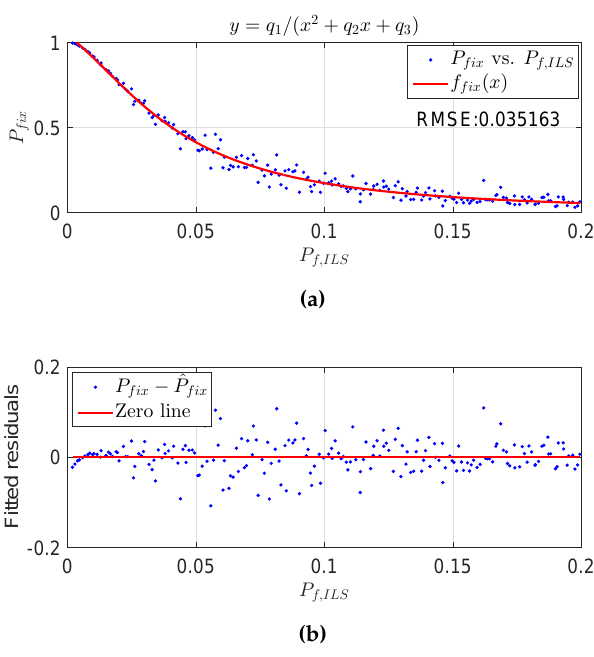
Figure 5. The fitting function of P fix against P f , ILS and its fitted residuals. P fix is resulted from µ min . The upper panel shows the fitted curve, and the lower panel shows the fitted residuals. The tolerable = 0.001, and the number of ambiguities is eight. ( a ) ˆ P failure rate P tol f vs. P f , ILS